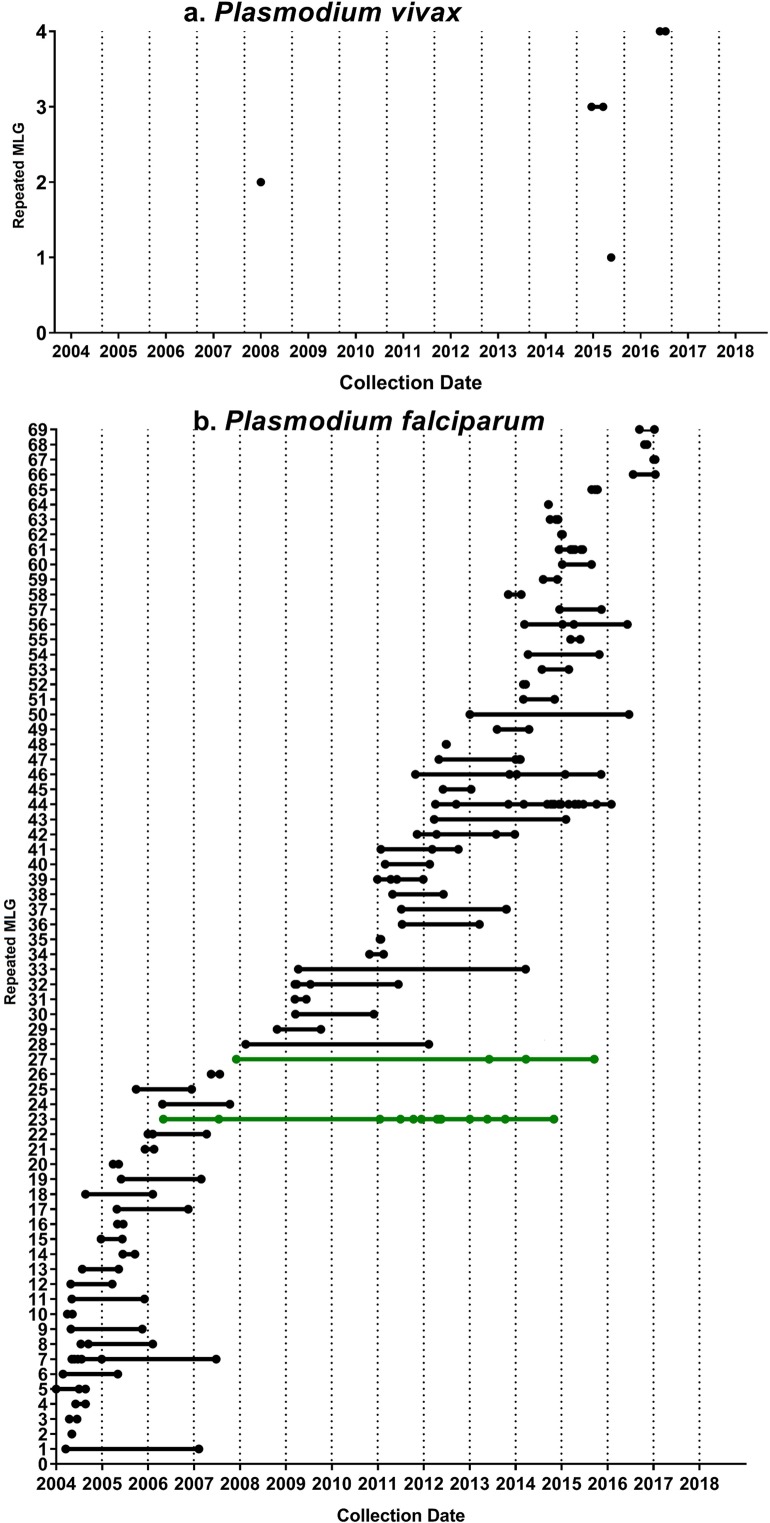
Persistence of repeated MLGs over time.Dot points illustrating the year when repeated MLGs were detected in each of a) P. vivax and b) P. falciparum. The P. vivax repeated MLGs were constructed across 8 loci, and the P. falciparum infections were constructed across 9 loci. The persistence of P. falciparum strains (repeated MLGs) reached up to 9 years (green) and was markedly greater than for P. vivax, which did not persist for over a year. However, most P. falciparum strains (repeated MLGs) had shorter duration (less than a year).